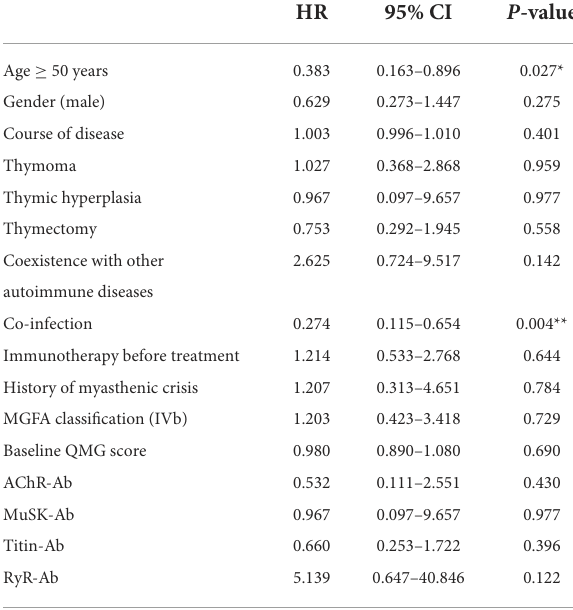
TABLE 2 Univariate logistic regression analysis of factors affecting LPE